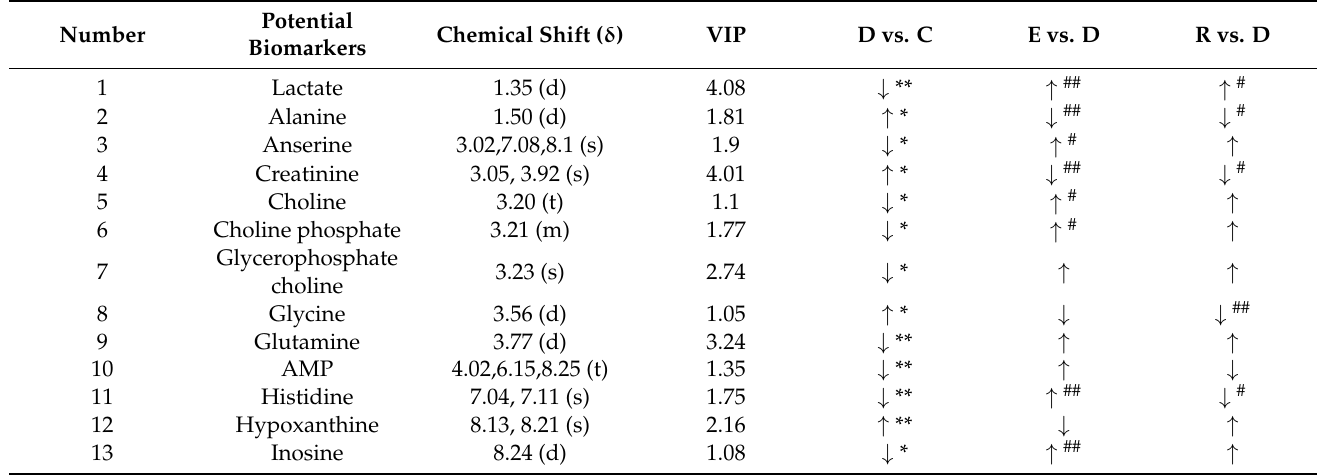
Table 2. Thirteen metabolites and their trends of change in the soleus